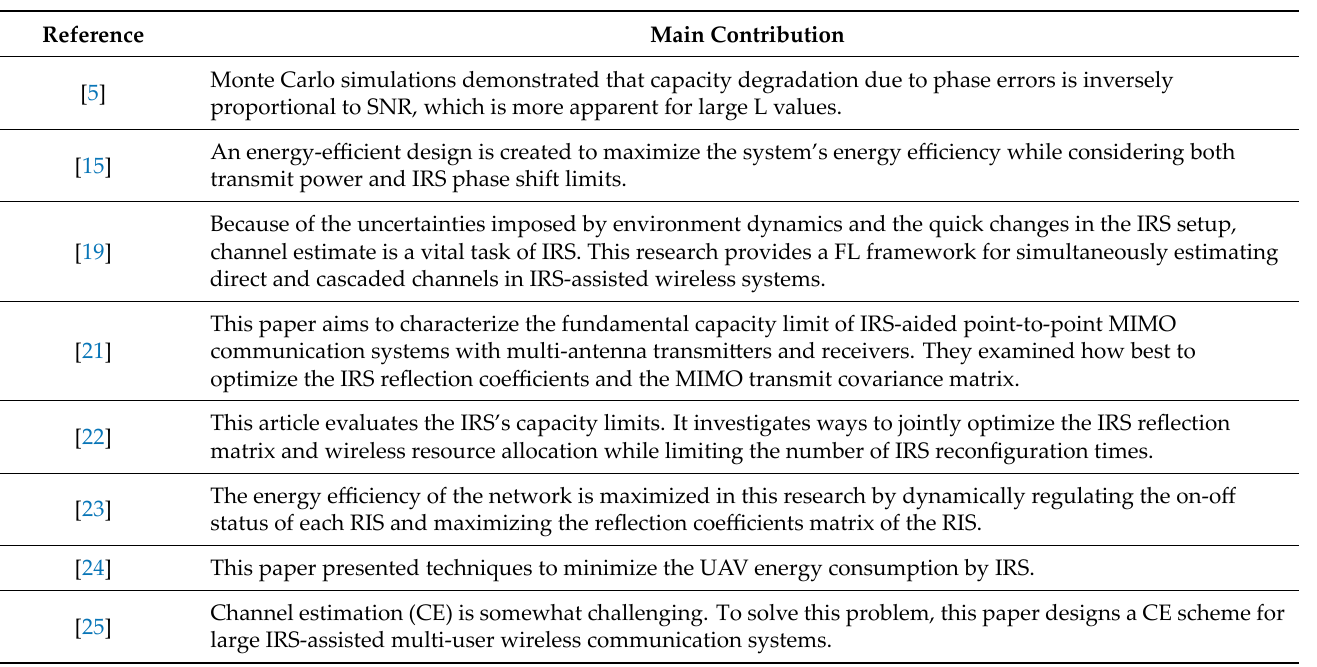
Table 1. Representative Overview of Recent Studies on an IRS.